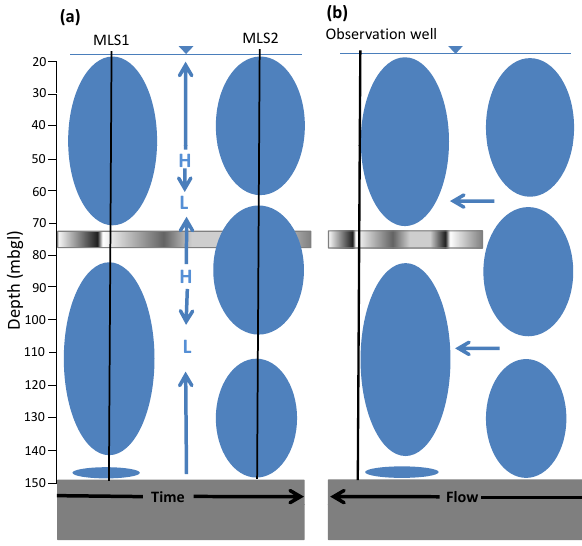
Fig. 8. Schematic representation of flow regime end members near the observation well. Blue ellipses present the water bodies inferred in the PCA of MLS1 (left) and MLS2 (right). (a) Vertical-dominant flow regime during the time between samplings that might support the differences in the vertical distribution of the water bodies ob- served in the two campaigns. “L” and “H” represent relatively low and high hydraulic heads, respectively. (b) Lateral flow of water bodies passing through the observation well as an alternative expla- nation of the differences. An arbitrary snapshot before MLS1 sam- pling date is presented. Note that MLS2 water bodies are assumed to originate from an area where the clayey bed at 73–79mb.g.l. is